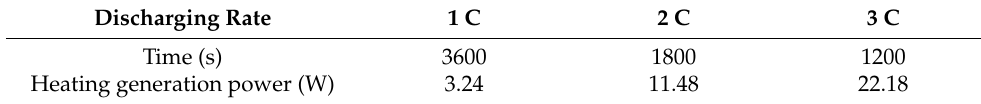
Table 2. Heating generation power of 40 Ah battery at different discharge rates.